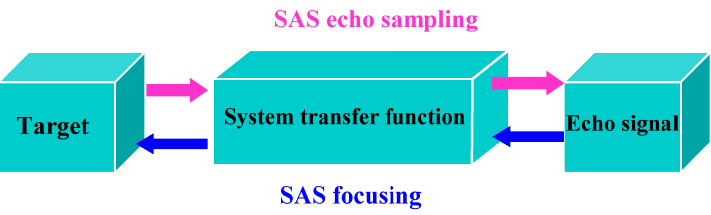
Figure 1. System model of SAS sampling and imaging.